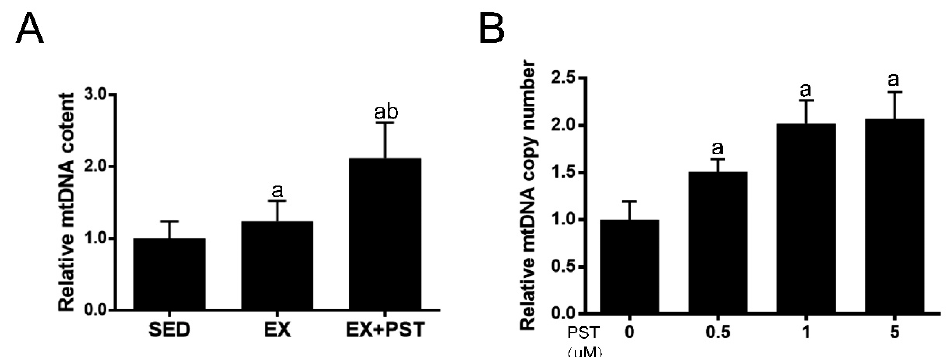
Figure 6. Effects of pterostilbene (PST) treatment on mitochondrial DNA copy number in muscle. Mitochondrial DNA copy number in the soleus ( A ) and C2C12 myotubes ( B ) were measured. Data are expressed as mean ± SD, a— p < 0.05 compared with the Sed group; b— p < 0.05 compared with the Ex group.